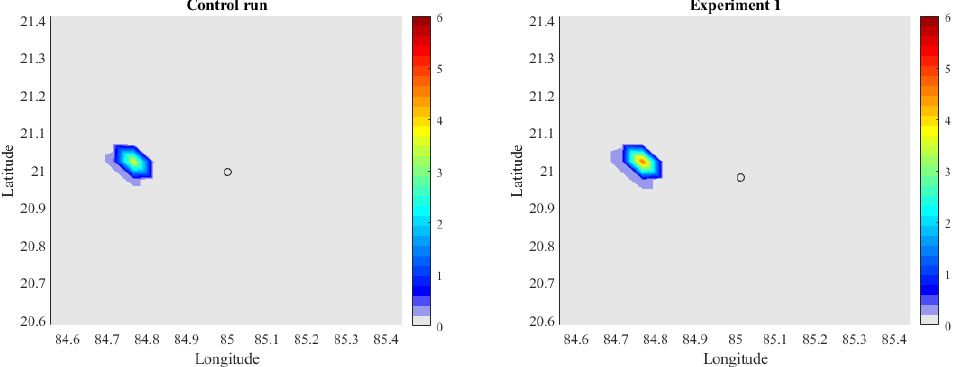
Figure 10. Rain rate (mm/h) comparisons for WDM6 on 22 March 2008 at near-surface level.